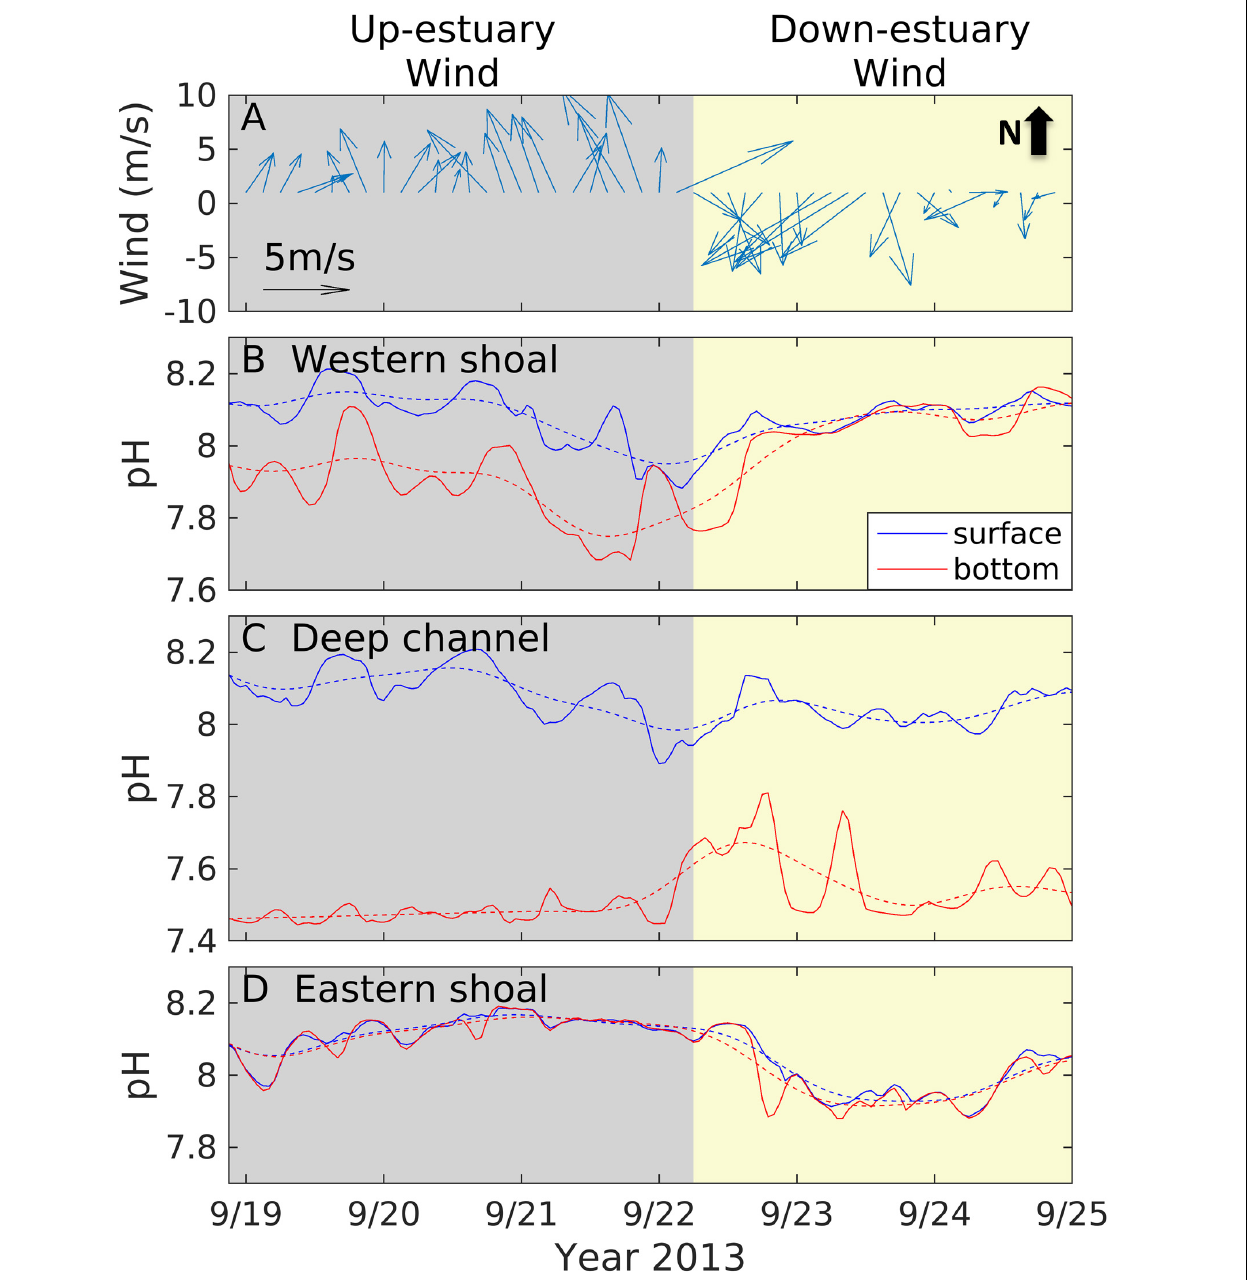
FIGURE 2 | Time series of wind speed vector (A) , surface (blue) and bottom (red) pH at a location on the western shoal (B) , in the center channel (C) , and on the eastern shoal (D) in a mid-Bay section (marked as black line in Figure 1A ). The three locations are further marked as red dashed lines in Figure 4D . The solid lines are original time series including tidal fluctuations and the dashed lines are low-passed with a 34-h Butterworth filter.